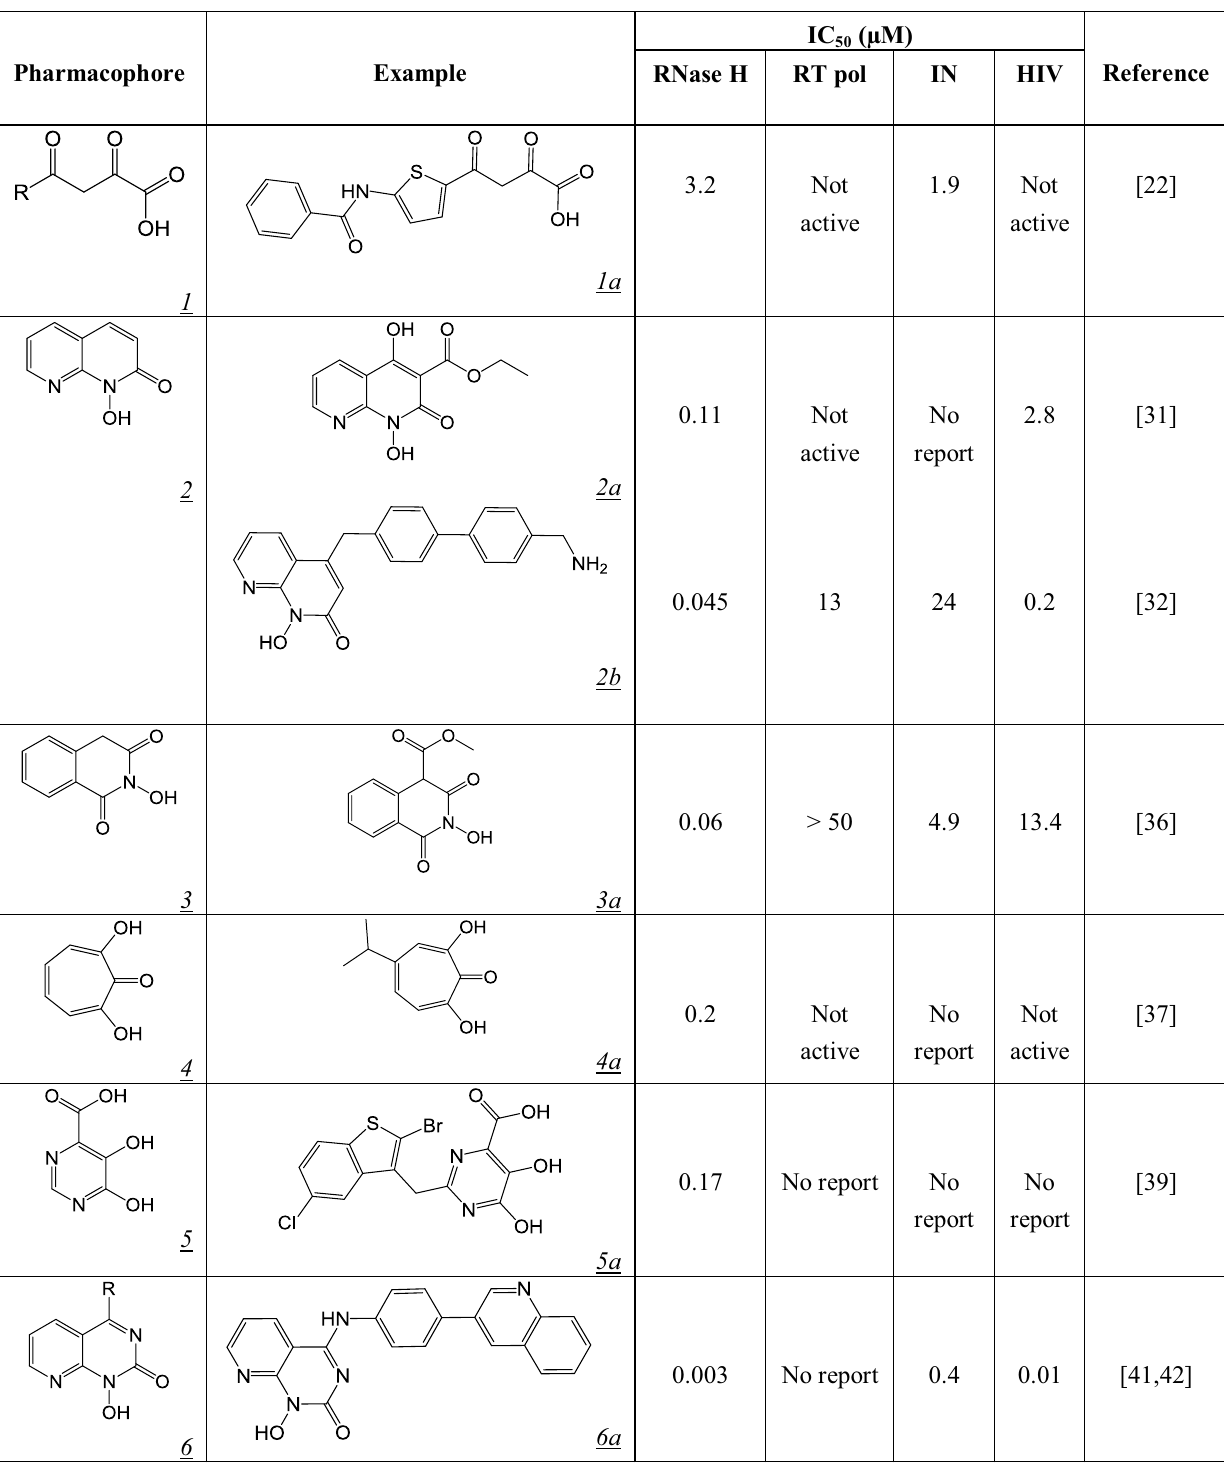
Table 1. Active site inhibitors of HIV RT RNase